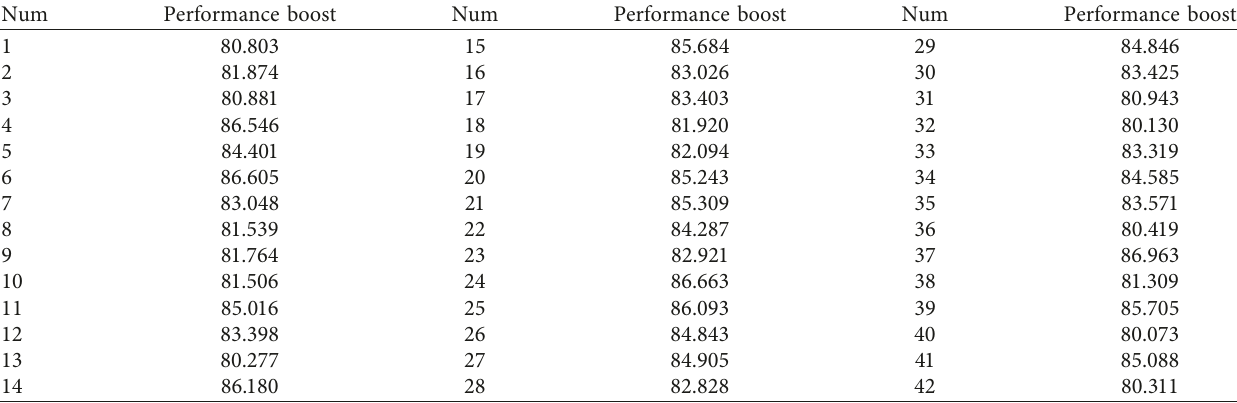
Table 3: Evaluation of the effect of the electronic component performance optimization system based on the improved GA. Num Performance boost Num Performance boost